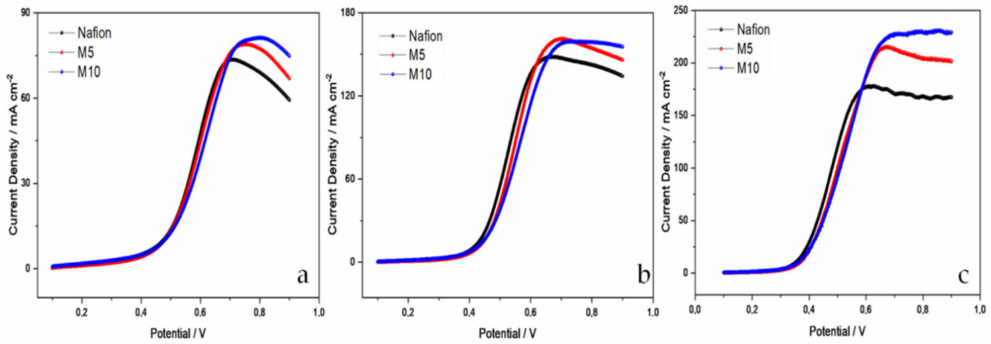
Figure 6. Methanol crossover current densities at ( a ) 30 ◦ C, ( b ) 60 ◦ C and ( c ) 90 ◦ C for the composite membranes compared with the filler-free Nafion in the presence of 2M methanol.